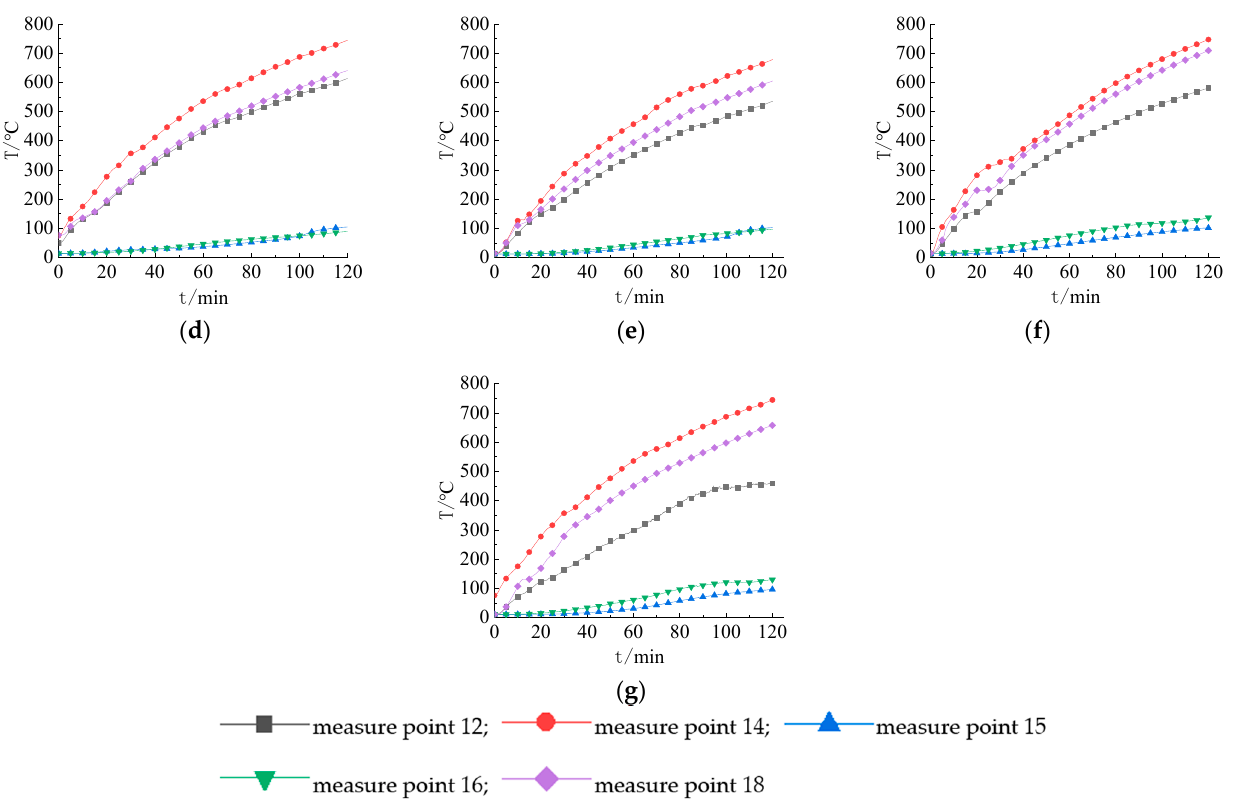
Figure 13. Time history curves of rebar temperature inside specimens: ( a ) SSB-1; ( b ) SSB-2; ( c ) SSB-3; ( d ) CB-1; ( e ) CB-2; ( f ) CB-3; ( g ) CB-4 .